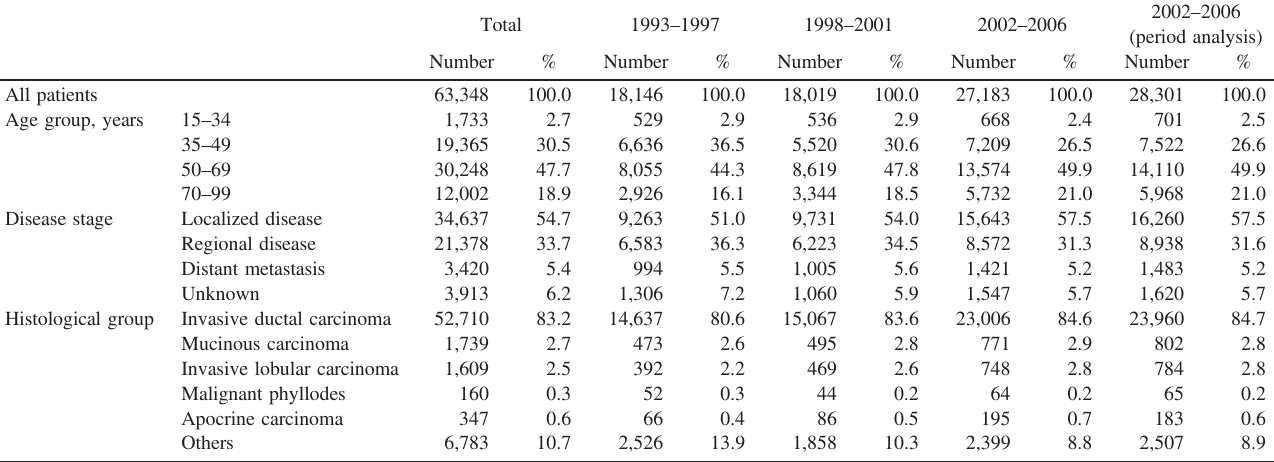
Table 1. Characteristics of female breast cancer patients from six prefectural population-based cancer registries